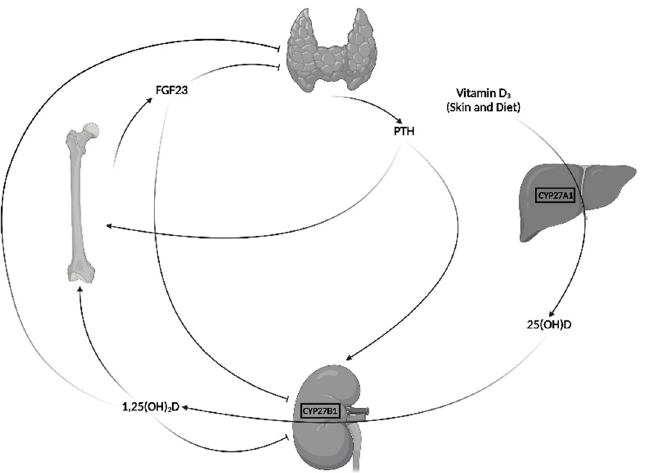
Figure 1. Parathyroid hormone (PTH)—vitamin D, fibroblast growth factor 23 (FGF23) feedback system. Lines ending in (cid:96) ndicate inhibitory effect. 25(OH)D: 25-hydroxyvitamin D. 1,25(OH) 2 D: 1,25-dihydroxyvitamin D. CYP27A1: cytochrome P450 family 27 subfamily A member 1. CYP27B1: cytochrome P450 family 27 subfamily B member 1. Figure created with BioRender.